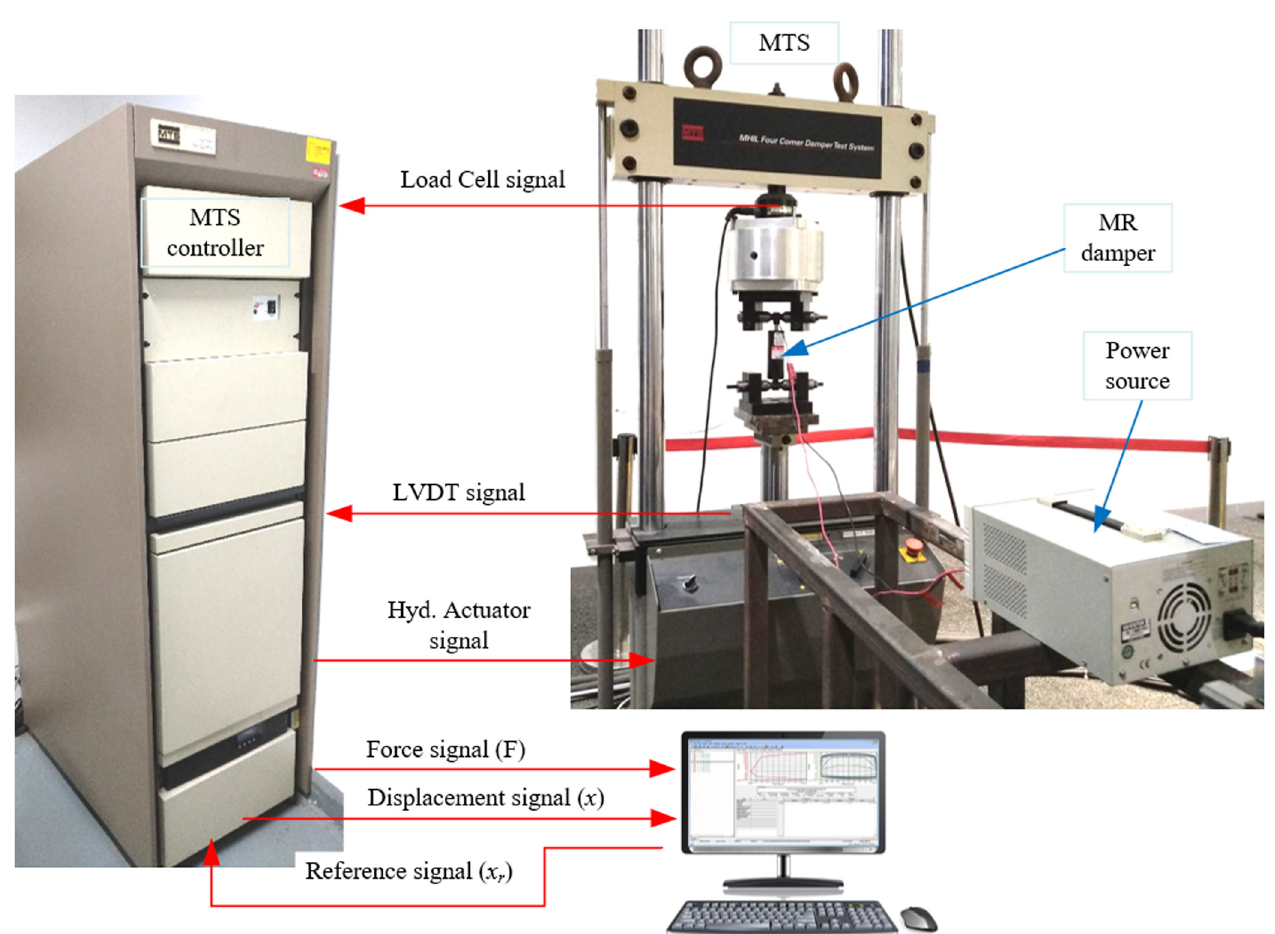
Fig. 4. Experiment on dynamic characteristics of the